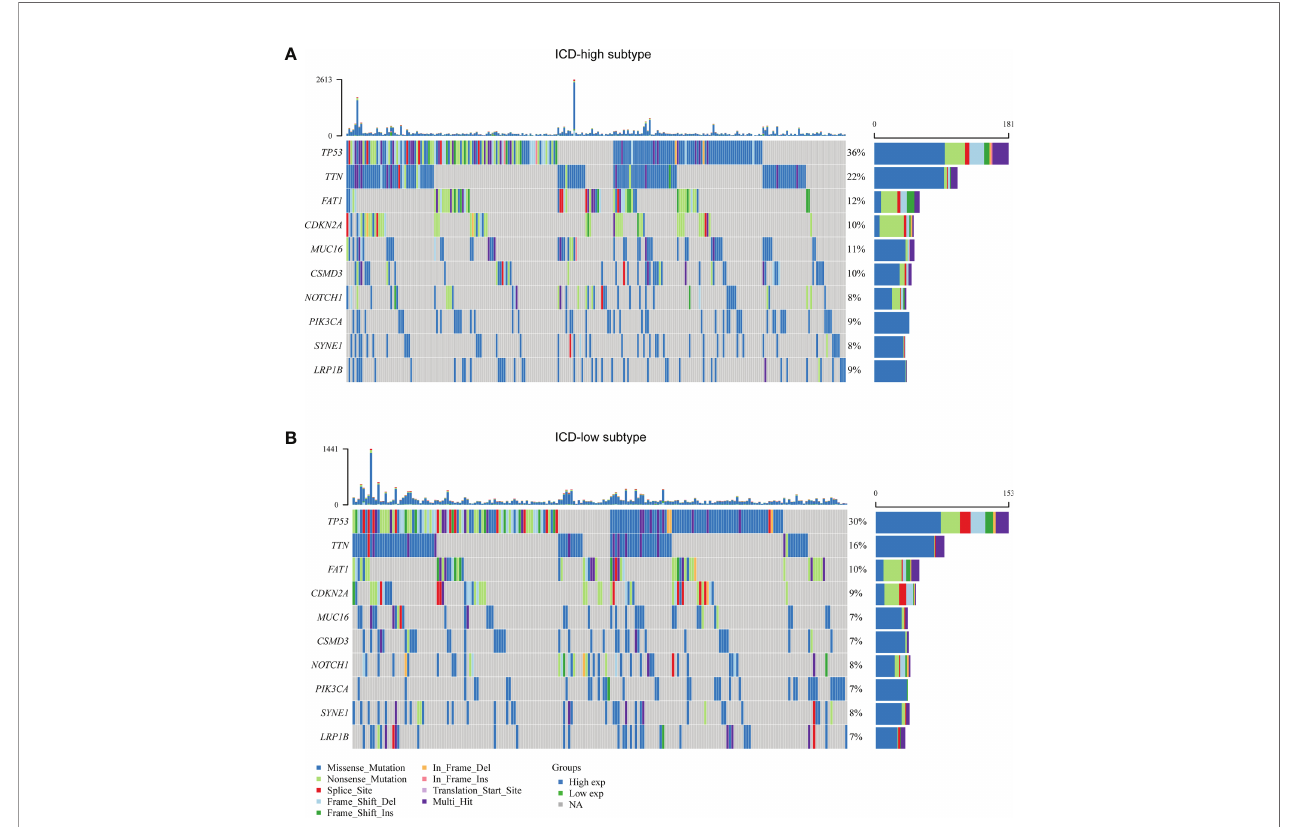
FIGURE 3 | Comparison of somatic mutations between different ICD subtypes. (A, B) Oncoprint visualization of the top ten most frequently mutated genes in ICD- high subtype (A) , and ICD-low subtype (B)